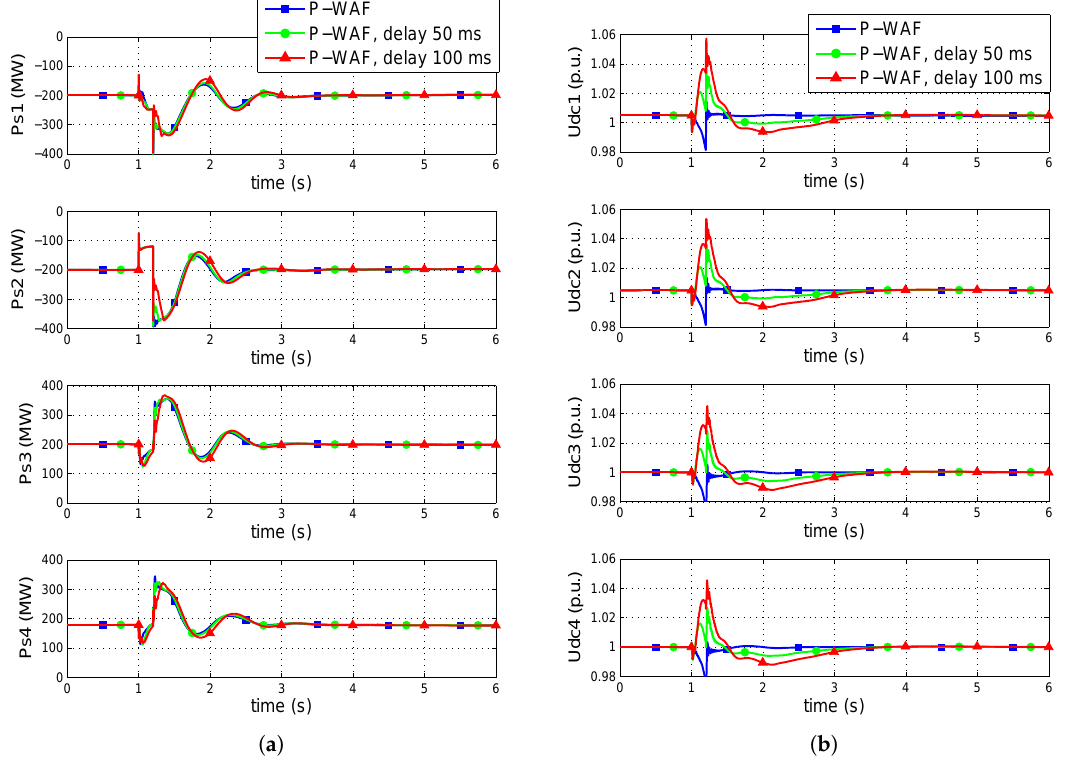
Figure 14. ( a ) P injections of the converters and ( b ) DC